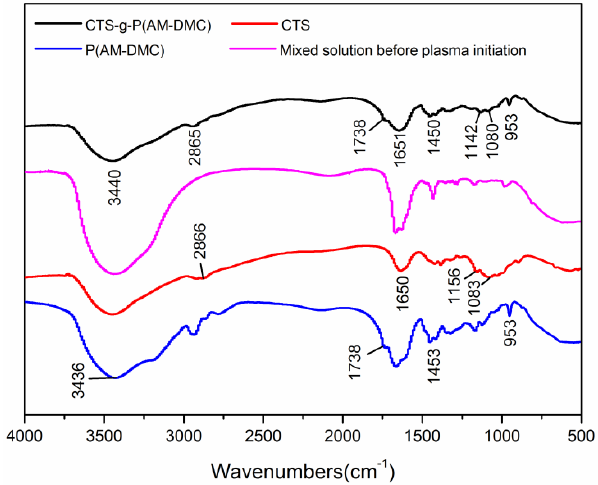
Figure 2. Fourier transform infrared spectroscopy (FTIR) spectra of CTS- g -P(AM-DMC), CTS, P(AM-DMC), and the mixture